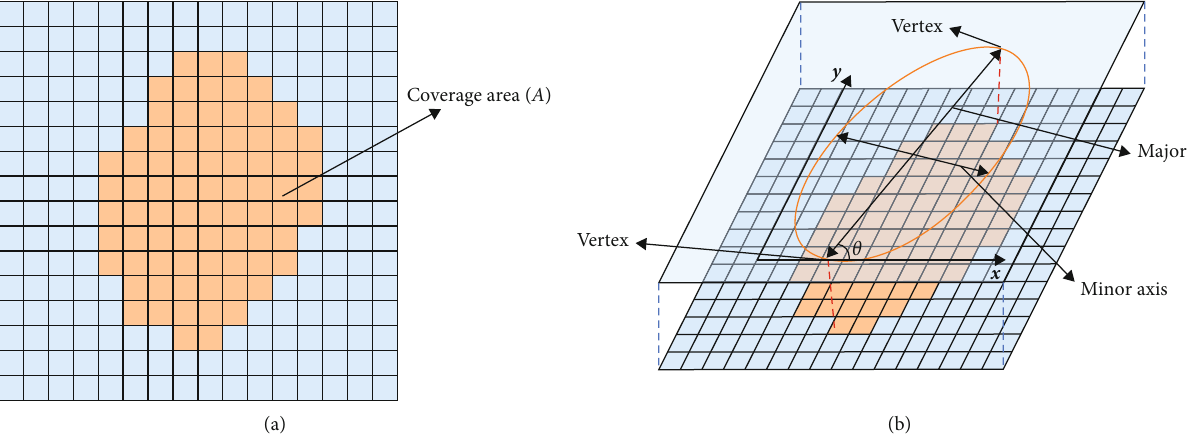
Figure 5: Schematic of particle/pore analysis: (a) digitized microfabric image and (b) de fi nitions of microstructural parameters of the